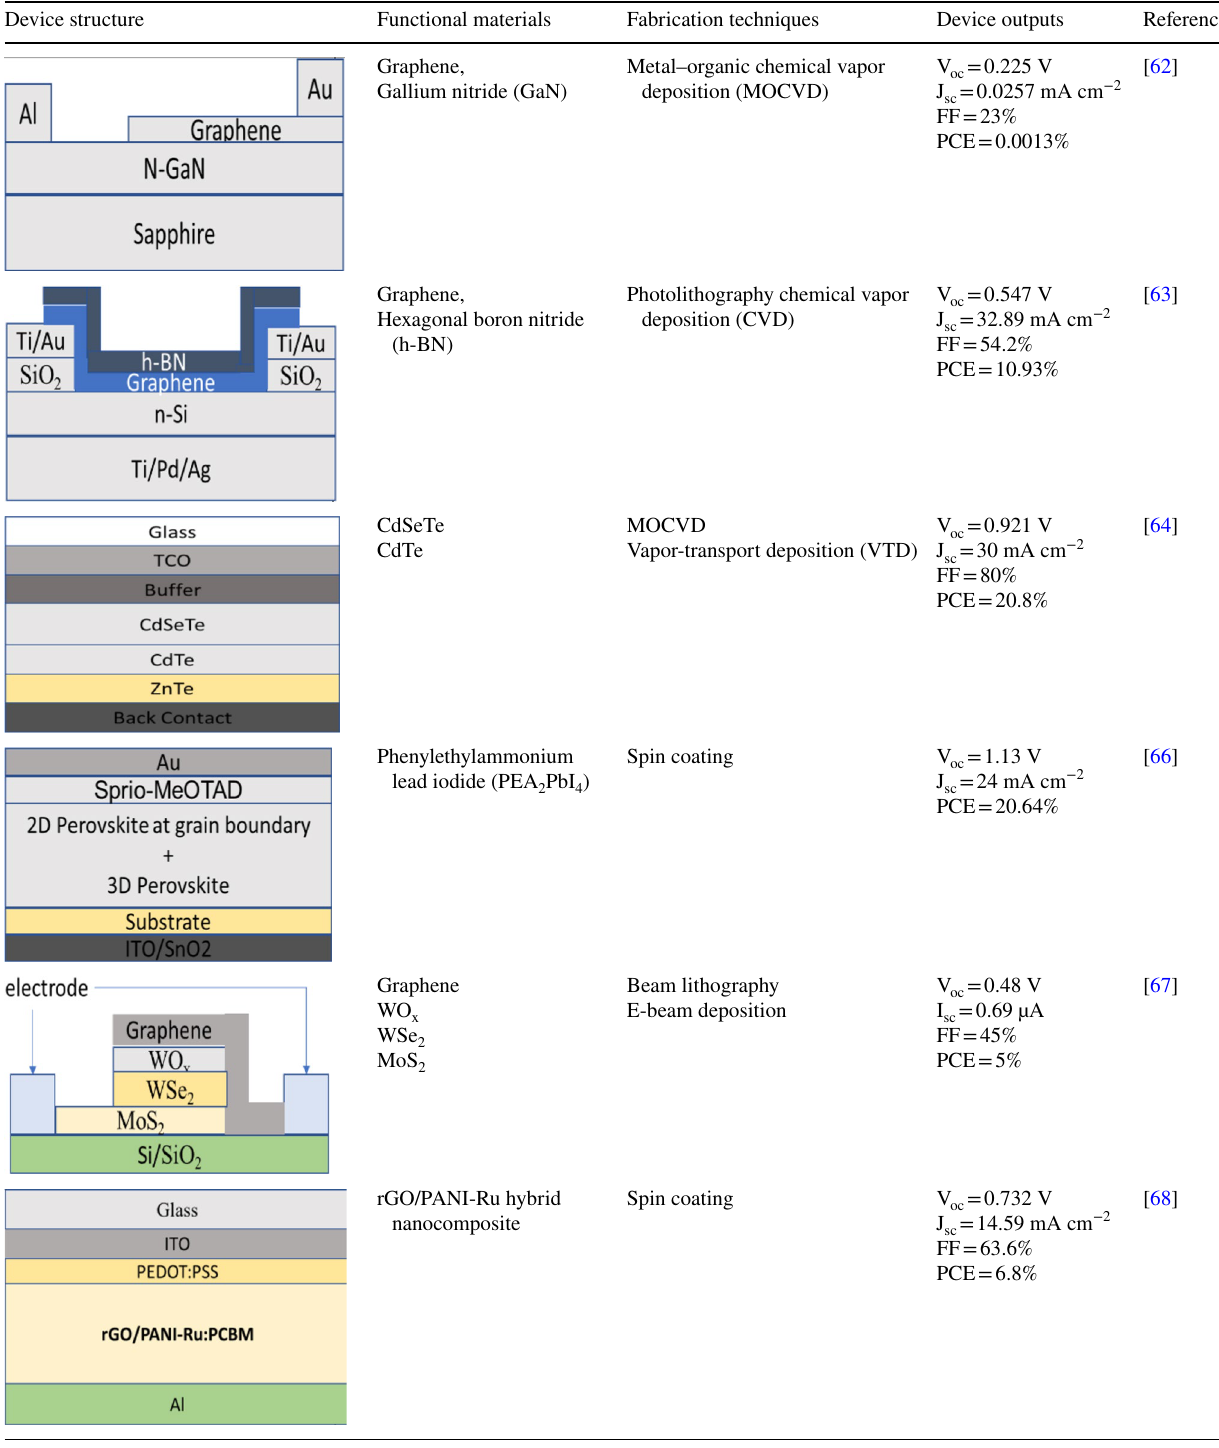
Table 1 Comparative summary of reported work on solar energy harvesting including device structure, functional materials, fabrication tech- niques, and device outputs Device